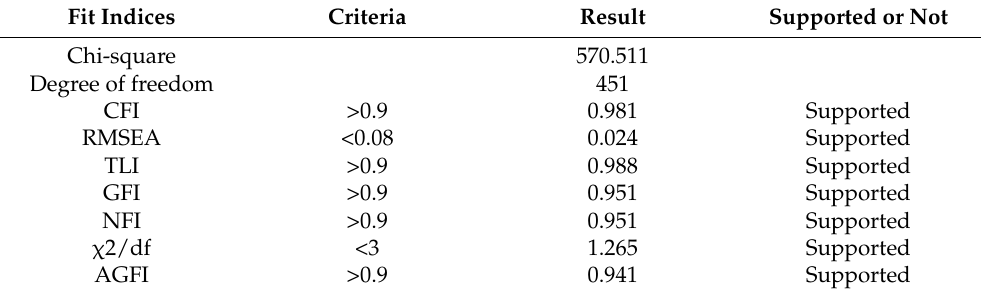
Table 5. Research hypothesis results.